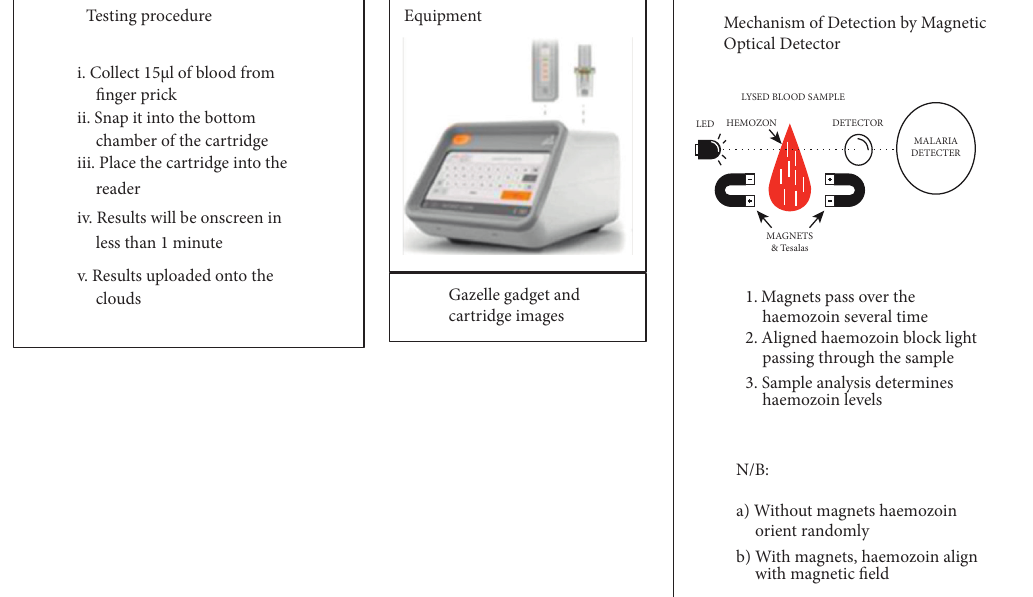
Figure 4: The Gazelle device, the testing technique, and the mechanism of hemozoin detection by magneto-optical detector are all adequately represented here